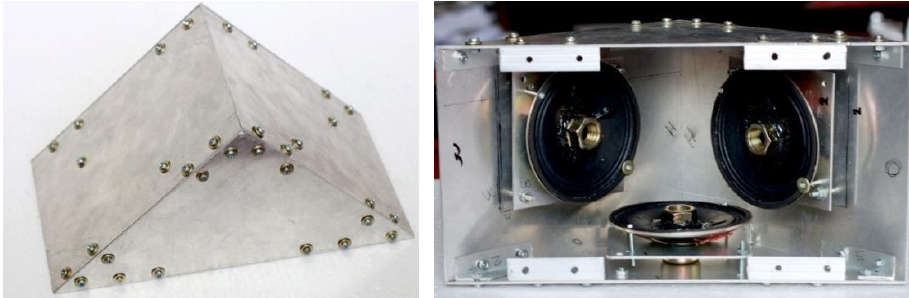
Figure 8. Physical design view of vibration sensor: outside view (left), inside view